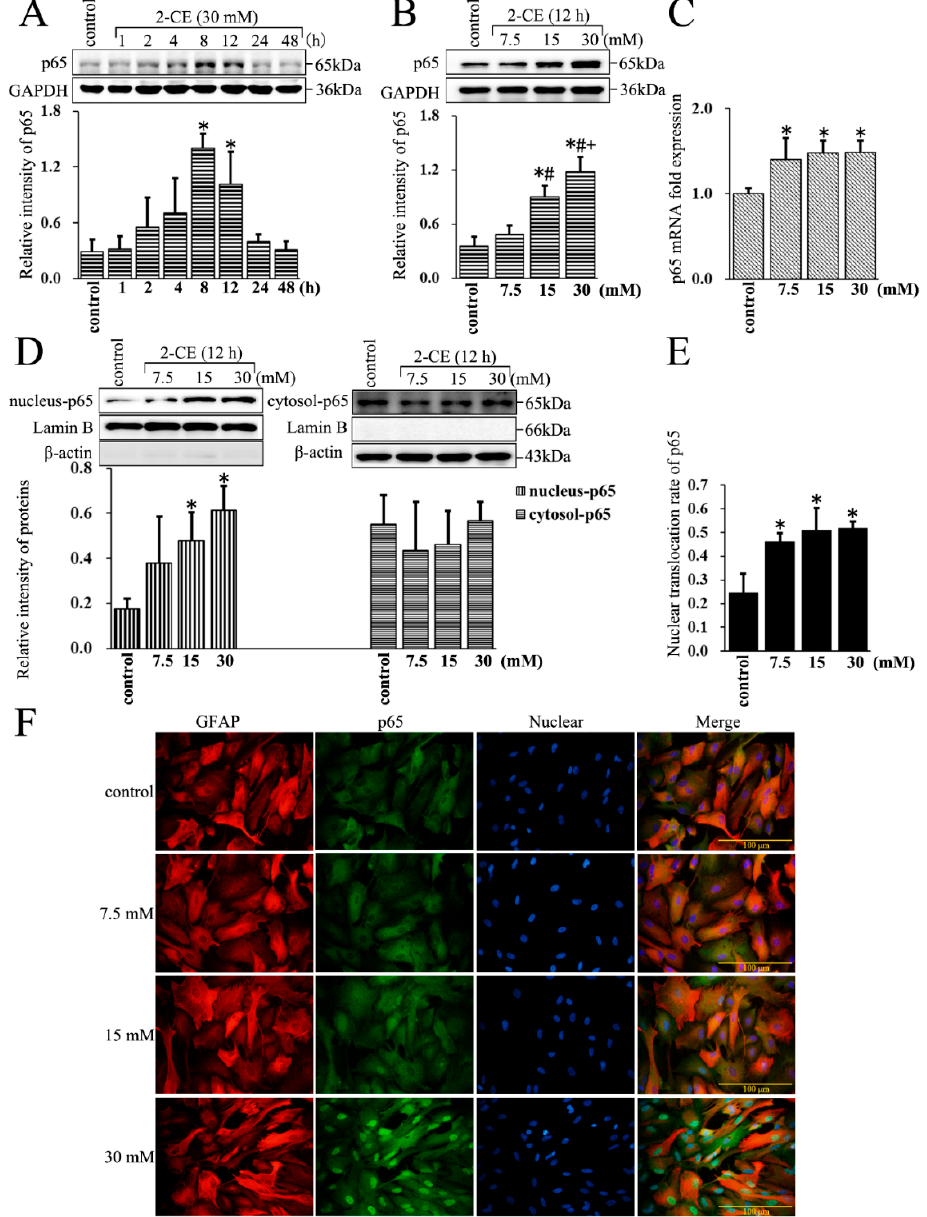
Figure 2. The nuclear translocation of p65 affected by 2-CE in astrocytes. ( A ) Astrocytes were treated with 30 mM of 2-CE for the indicated times, and ( B – F ) with 0, 7.5, 15, and 30 mM 2-CE for 12 h; ( A , B